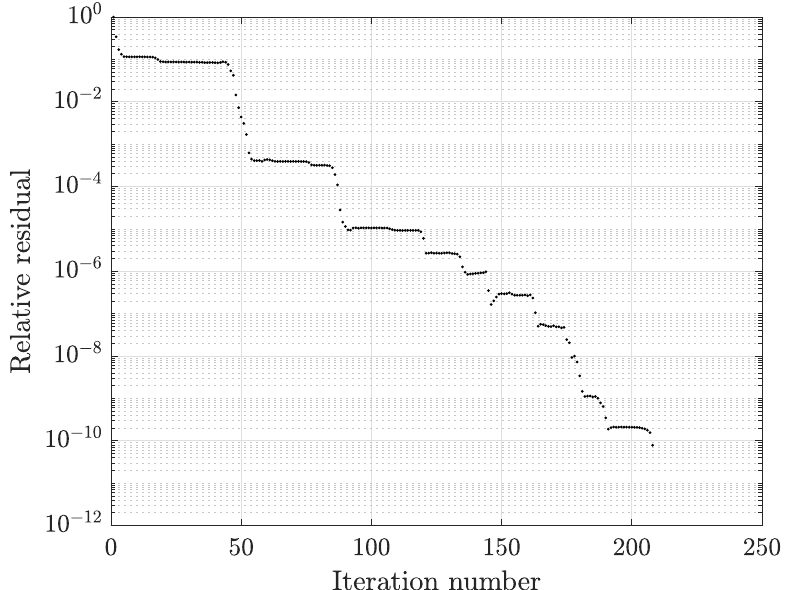
Figure 9. Convergence pattern of the TFQMR solver with SSOR preconditioning at 200 Hz (CM-BEM software with R-SVD compression, coarsest mesh: 69,492